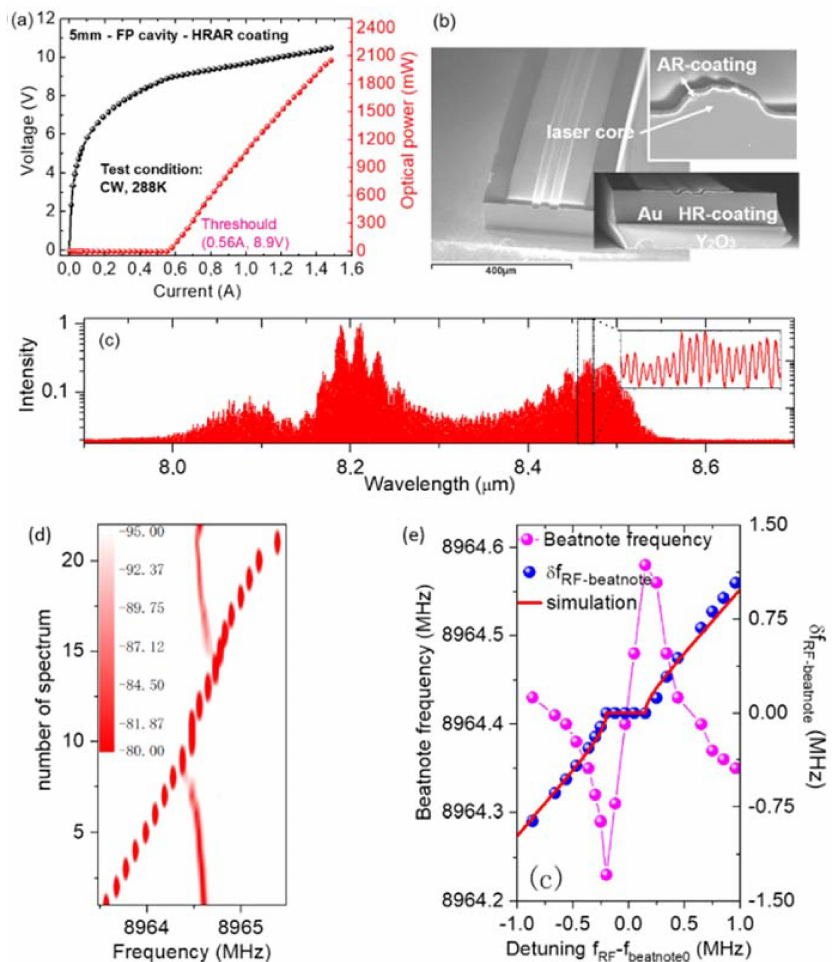
Figure 2. ( a ) The light-current-voltage (LIV) curves of a quantum cascade laser operating at room temperature in continuous wave. ( b ) The scanning electron microscope (SEM) image of the quantum cascade laser. ( c ) The spectrum of the laser. ( d ) The evolution of the beatnote (continuous branch) of the QCL as a function of the injected RF frequency (discrete branch) (each injected RF frequency can be found in the x axis). ( e ) Magenta: the beatnote frequency as a function of the detuning δ between RF frequency f RF and the beatnote without RF injection Δ f 0 . Blue: the frequency difference δ f RF − beatnote between RF and beatnote as a function of detuning δ . (Figure ( d , e ) from Ref [57], reprint with the permission of Optica publishing group).